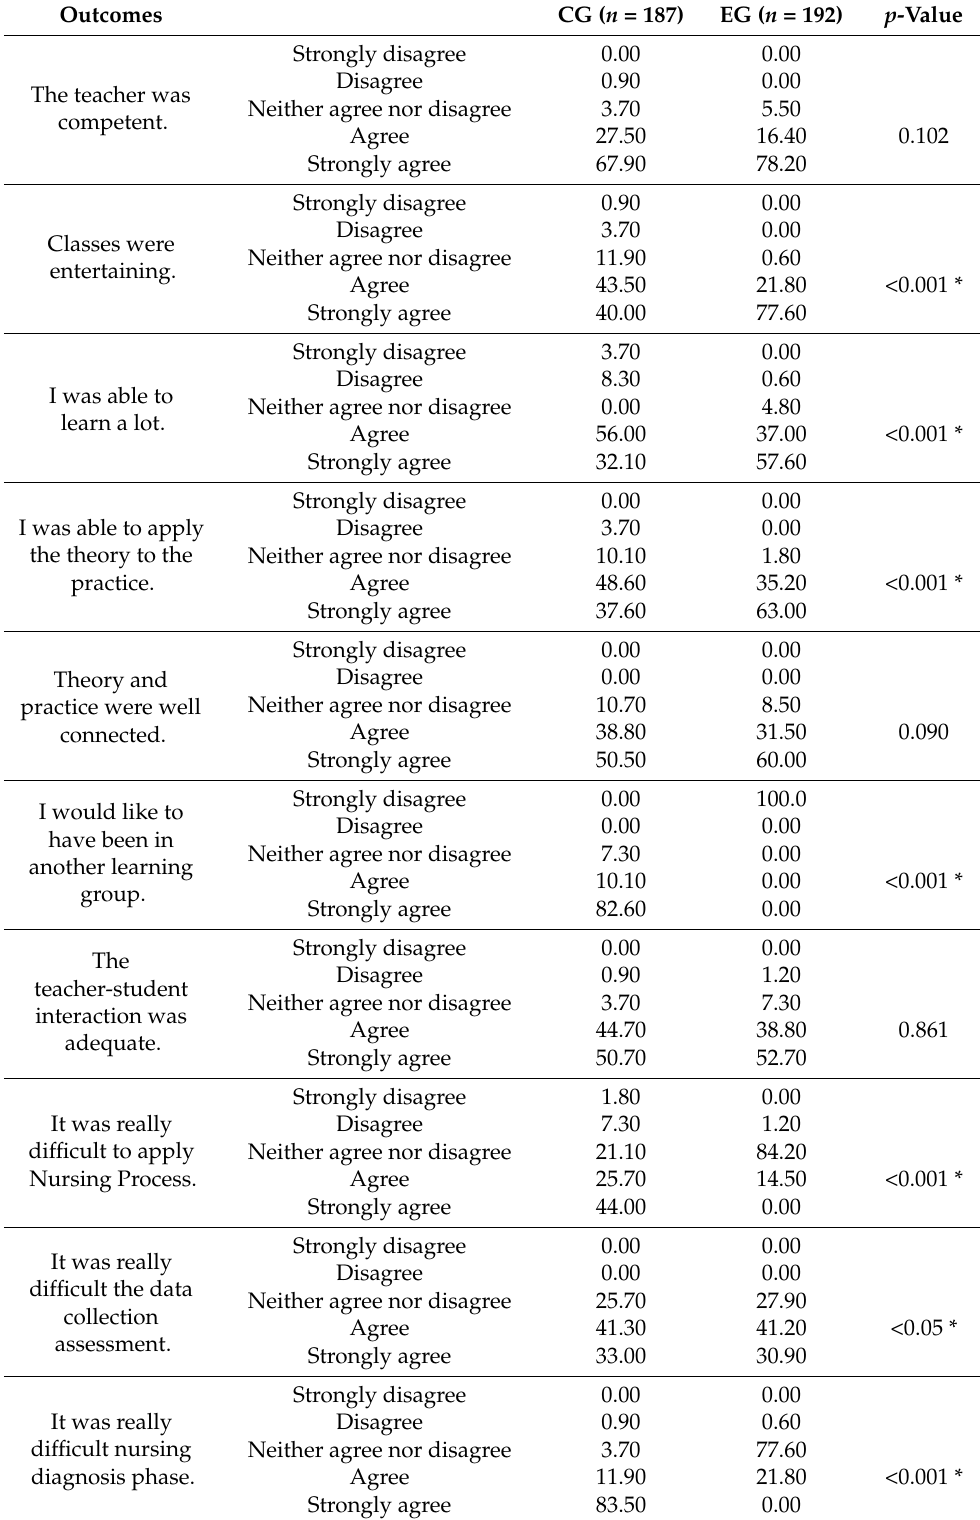
Table 1. Comparison of students’ satisfaction and perception between groups.